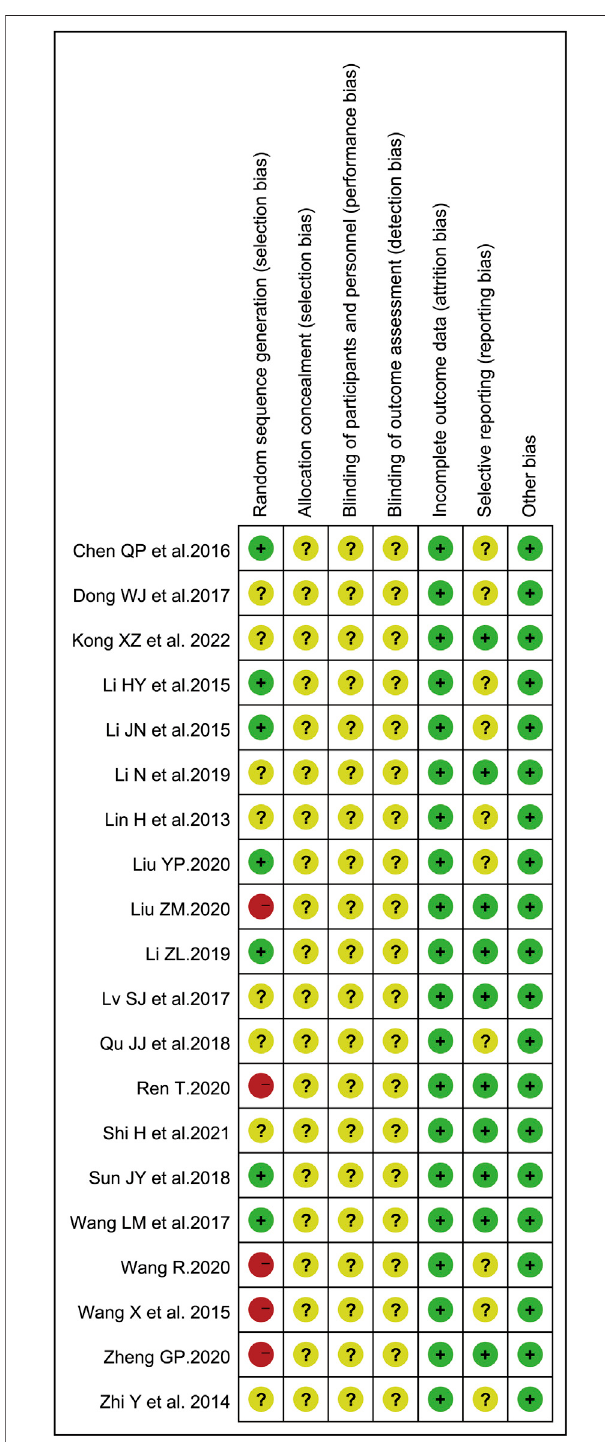
Figure 5B illustrated the effect of SFI on CRP (Lv et al., 2017; Wang, 2020; Kong et al., 2022). The pooled analysis, including